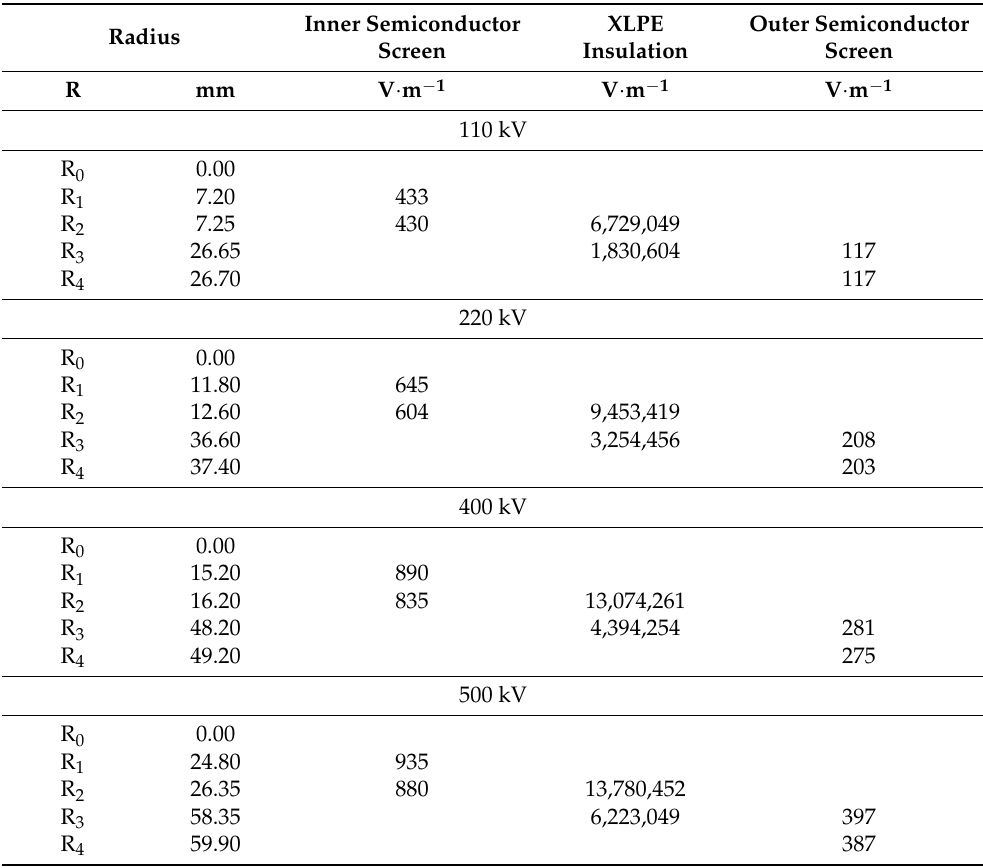
Table 4. Maximum E max and minimum E min values of electric field stress in semiconductor screens and XLPE insulation of high-voltage cables with 110, 220, 400, and 500 kV. Inner Semiconductor XLPE Outer Semiconductor Radius Screen Insulation